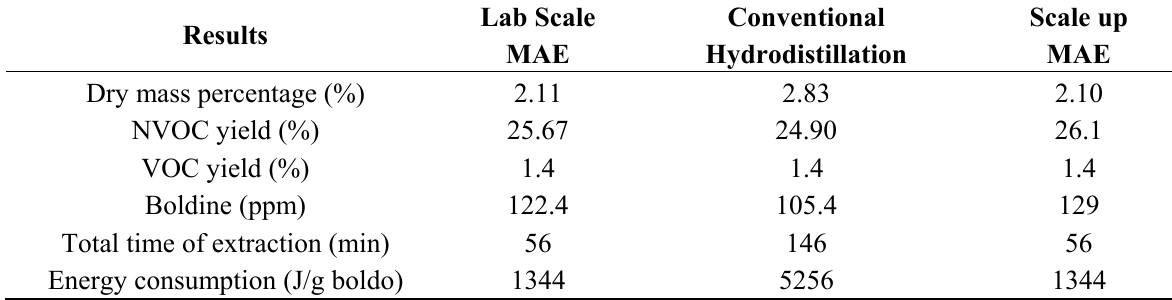
Table 2. Comparison between the different extractions procedures.